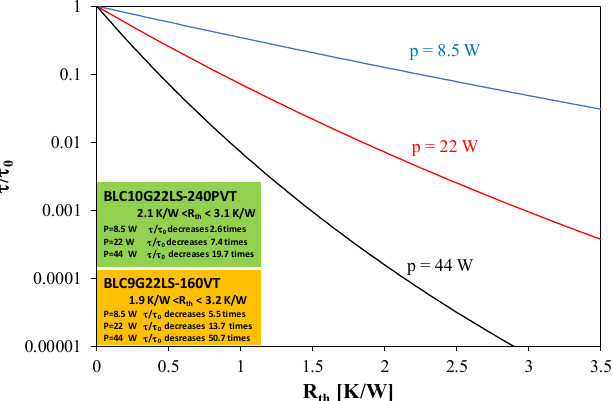
Figure 19. Relative change in the transistor lifetime as a function of thermal resistance.